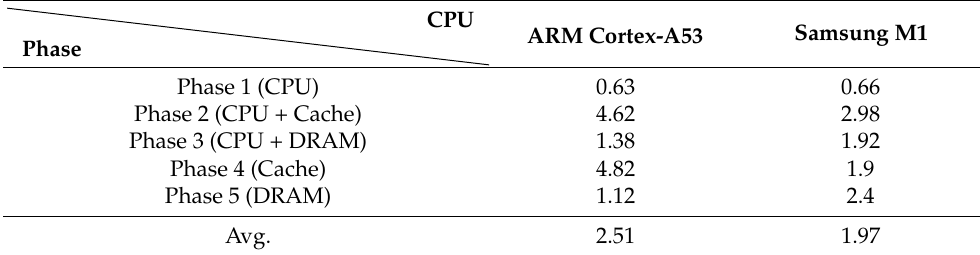
Table 4. Results of phase-specific CPU power models (unit: MAPE (%)).